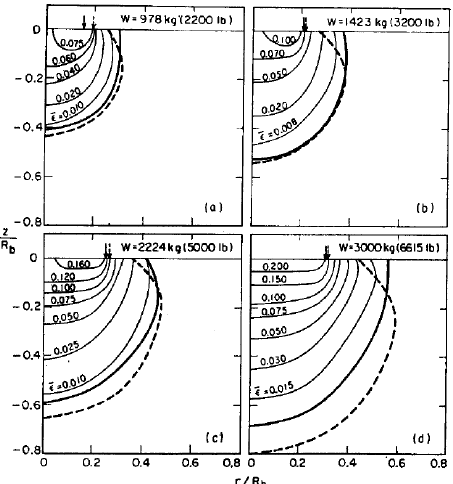
Figure 28. Strain contours and elastic-plastic boundaries under the load of ( a ) 978 kg; ( b ) 1423 kg; ( c ) 2224 kg and ( d ) 3000 kg (—FEM; ----experiment) [83]. Reproduced with permission